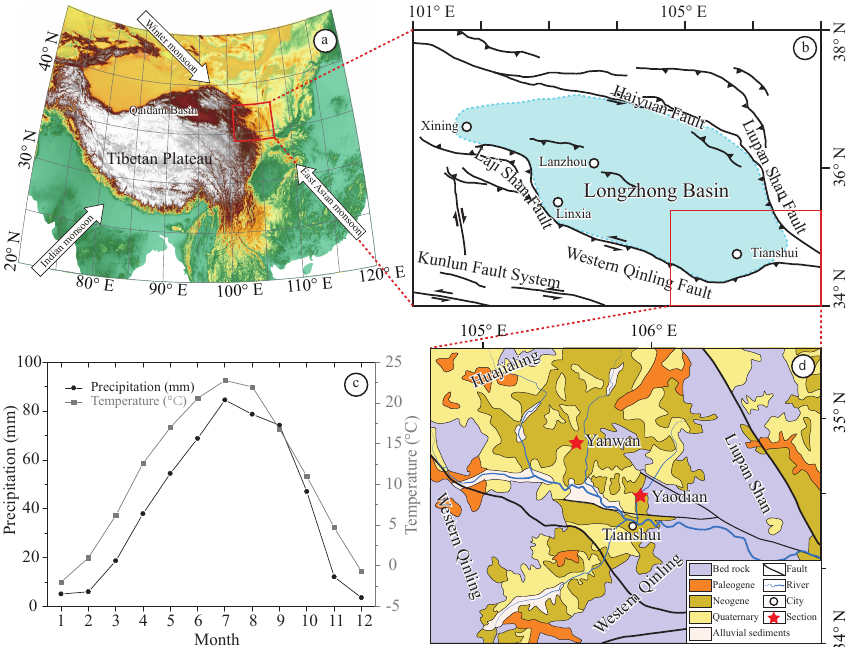
Figure 1. Geographic setting of Yaodian Section. (a) Location of the Longzhong Basin. (b) Major tectonic faults of the Longzhong Basin. (c) Mean monthly temperature and mean monthly precipitation in the Tianshui area, 1971–2000. (d) Geological map of the Tianshui